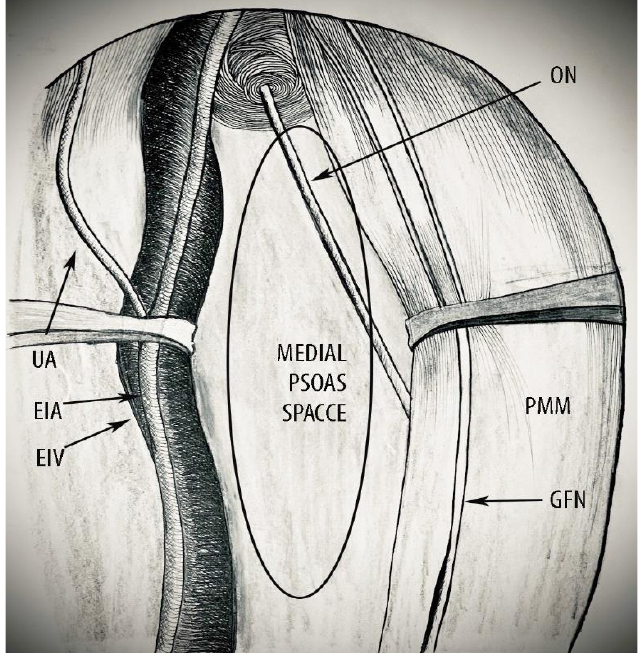
Figure 11. Boundaries of the medial psoas space (right pelvic sidewall). ON — obturator nerve;